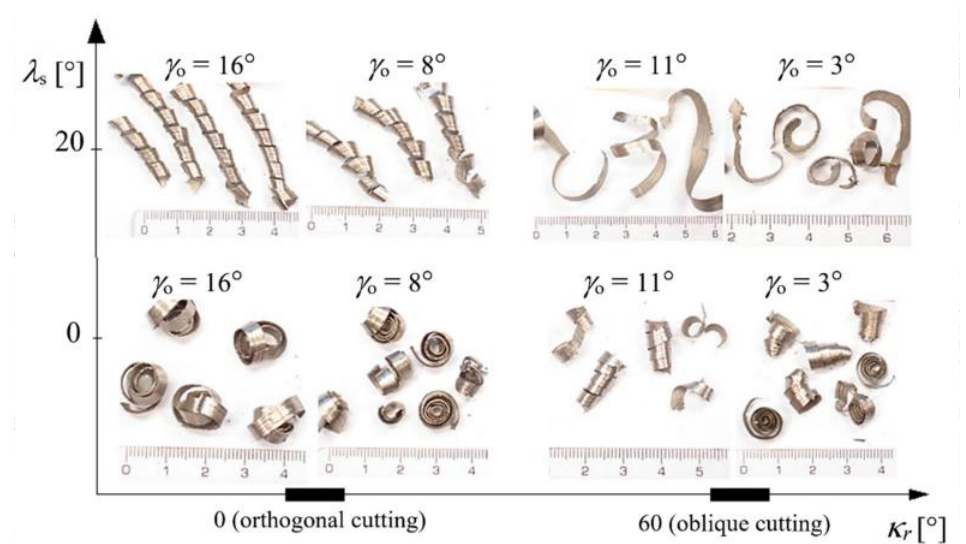
Figure 7. The shapes of chips of EN 16MnCr5 steel and their dependence on tool cutting edge angle κ r , angle of tool cutting edge inclination λ s , and angle of tool orthogonal rake γ o at a p = 0.2 mm, v c = 15 mmin − 1.